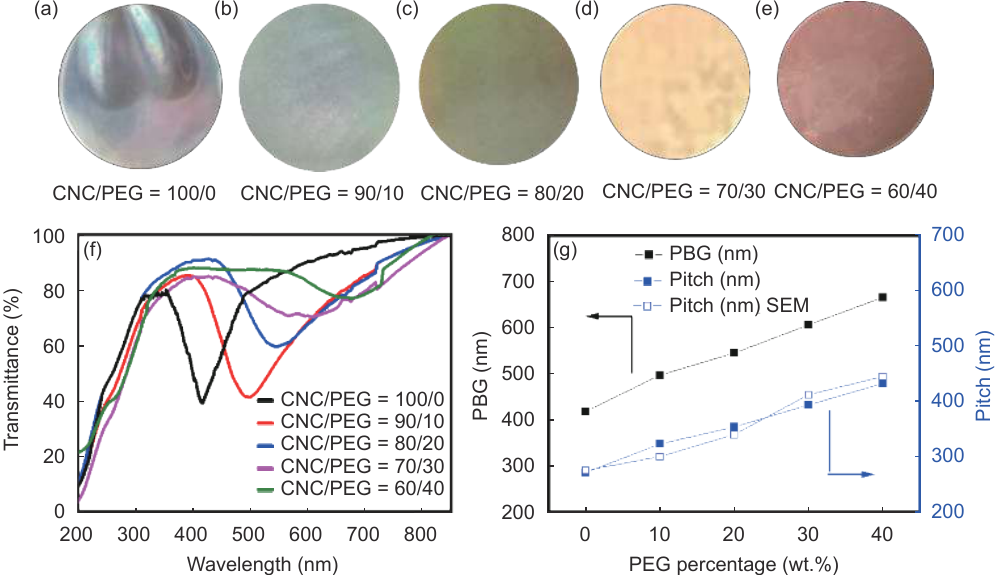
Figure 3 The pictures of CNC/PEG/EuW 10 composite films at ambient environment (RH ~ 13%): (a) CNC/PEG = 100/0; (b) CNC/PEG = 90/10; (c) CNC/PEG = 80/20; (d) CNC/PEG = 70/30; (e) CNC/PEG = 60/40. (f) Transmission spectra and (g) the relationship of PBG and pitch as a function of PEG